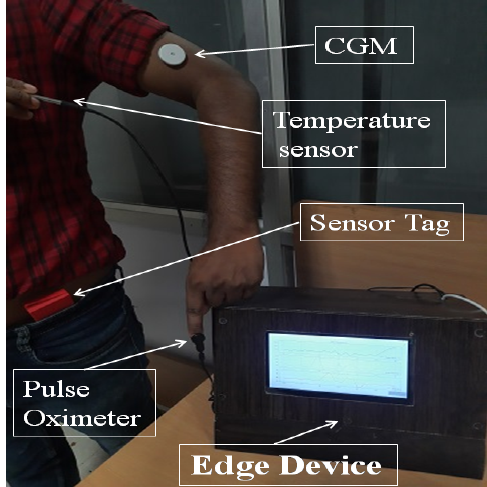
Figure 5. Real-time patient data collection system using temperature sensor, pulse oximeter, CGM, sensor tag, and Edge device to display the